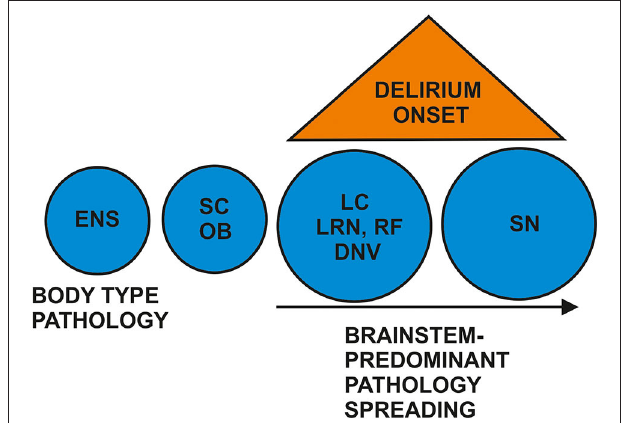
FIGURE 1 | Proposed brainstem predominant pathologies in prodromal DLB’s delirium onset. There is controversy about whether neuropathology starts in the enteric nervous system (ENS) as first-body pathology or in the brain such as in the olfactory bulb (OB) or brainstem. However, postulating a brainstem-type of Lewy body pathology in prodromal DLB with delirium, we propose Lewy body pathology and degeneration affecting the spinal cord (SC), dorsal motor nucleus of the vagus nerve (DNV), magnocellular reticular formation (RF), lower raphe nuclei (LRN), and the locus coeruleus (LC). The substantia nigra (SN) is more likely to be affected later than the